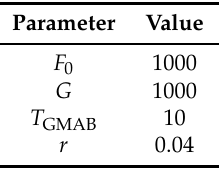
Table 3. General contract details of the GMAB rider.